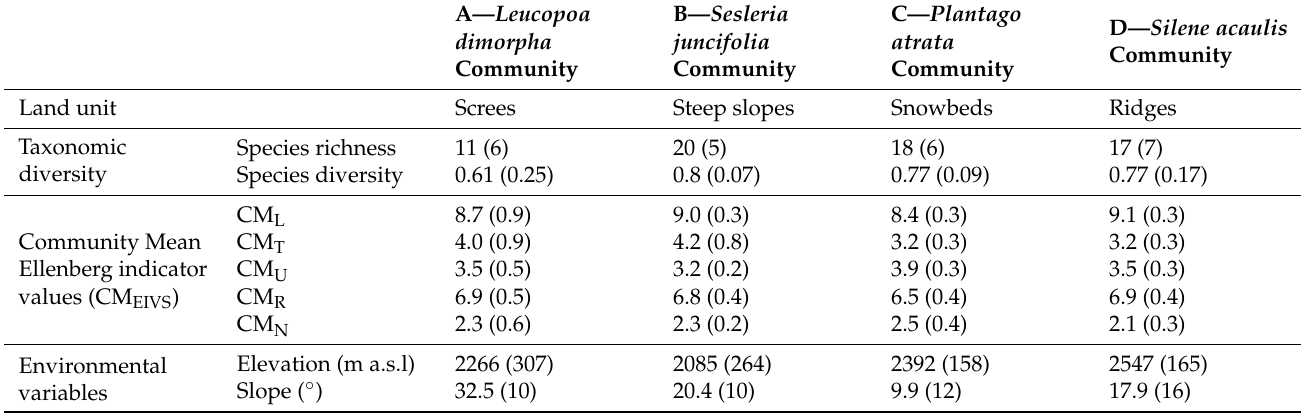
Table 1. Brief description of the analyzed plant communities (A: Leucopoa dimorpha community, B: Sesleria juncifolia community, C: Plantago atrata community, D: Silene acaulis community) occurring in the different land units (according to Stanisci et al. [42]) in terms of taxonomic diversity (species diversity reported as 1-Simpson), community mean for Ellenberg indicator values (CM EIVs ) for Italian flora [55] calculated with presence/absence species data (L, light; T, temperature; U, soil moisture; R, soil reaction; N, soil nutrients) and local environmental features registered at plot level. Mean plot values along with standard deviation (in brackets) are